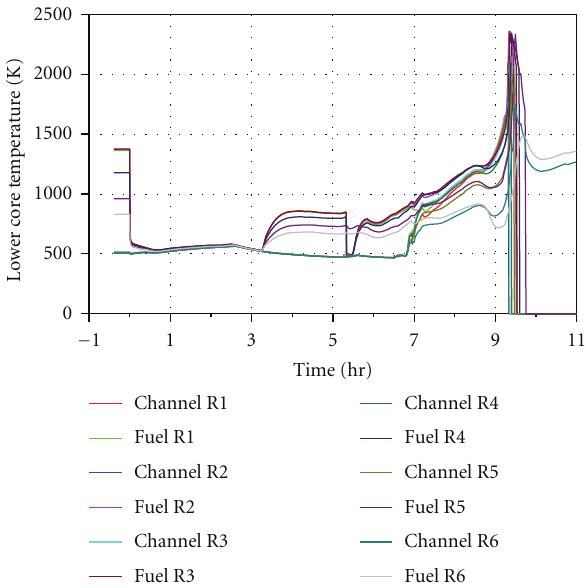
Figure 22: Temperature of fuel and coolant channels in R1 to R6 of lower core.